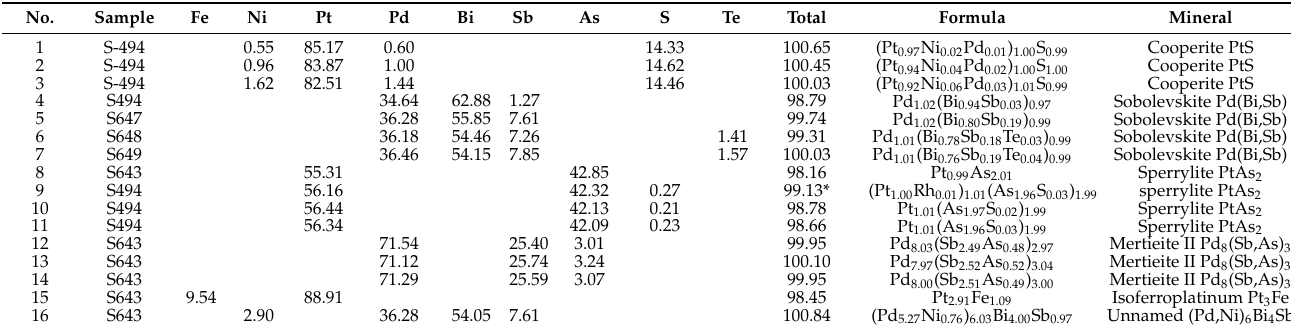
Table 4. Composition of PGM of the Skalisty mine